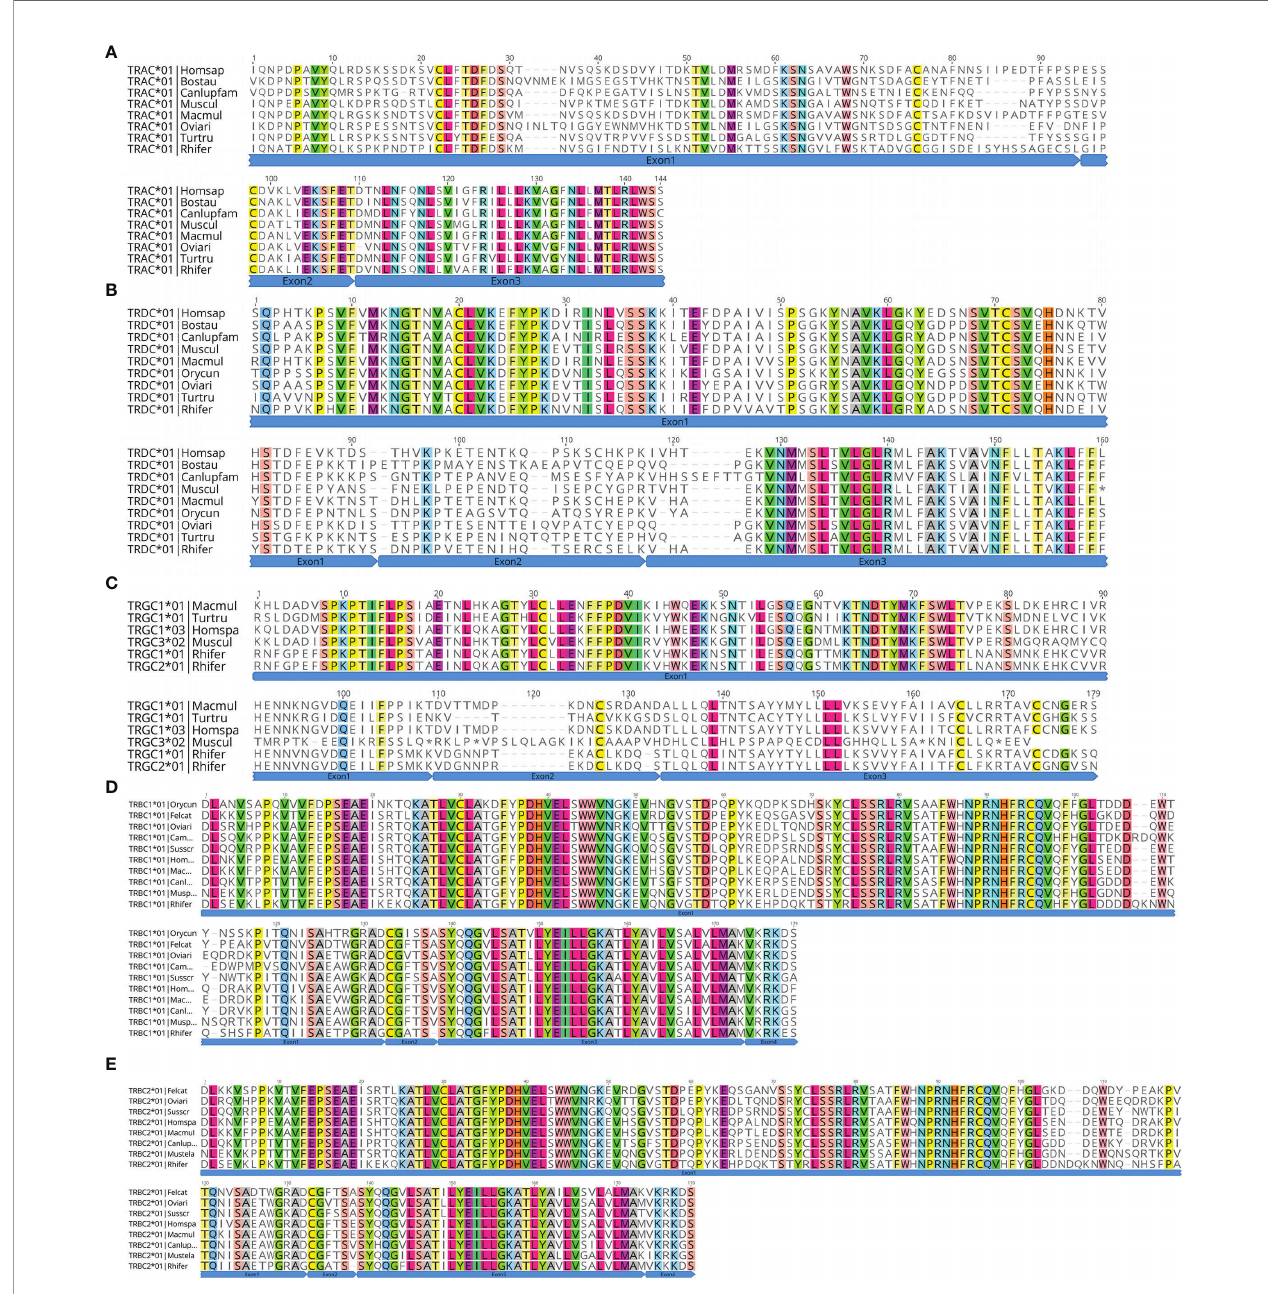
FIGURE 8 | Deduced amino acid sequences of the bat TRAC (A) , TRDC (B) , TRGC (C) , TRBC1 (D) , and TRBC2 genes (E) . Rhinolophus ferrumequinum , Rhifer; Homo sapiens , Homspa; Mus musculus , Muscul; Bos taurus , Bostau; Camelus dromedarius , Camdro; Tursiops truncatus , Turtru; Oryctolagus cuniculus , Orycun; Sus scrofa , Susscr; Ovis aries , Oviari; Macaca mulatta , Macmul; Felis catus , Felcat; Mustela putorius furo , Musputfur; Canis lupus familiaris ,